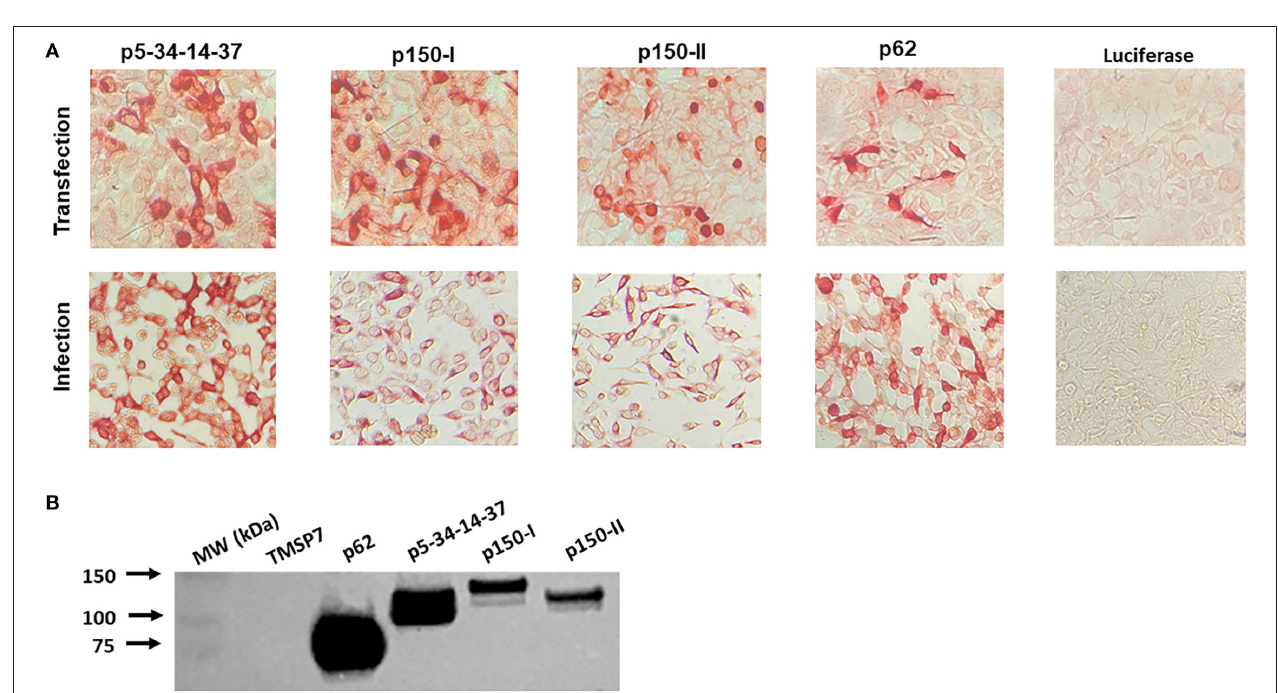
FIGURE 2 | ASFV pp220 construct antigen expression. (A) Antigen expression was evaluated by immunostaining of HEK 293A cells transfected with pcDNA or infected with adenovirus encoding each pp220 construct, and (B ) Western Blot, using proteins produced by transfected HEK 293A cells, probed with ASFV-specific